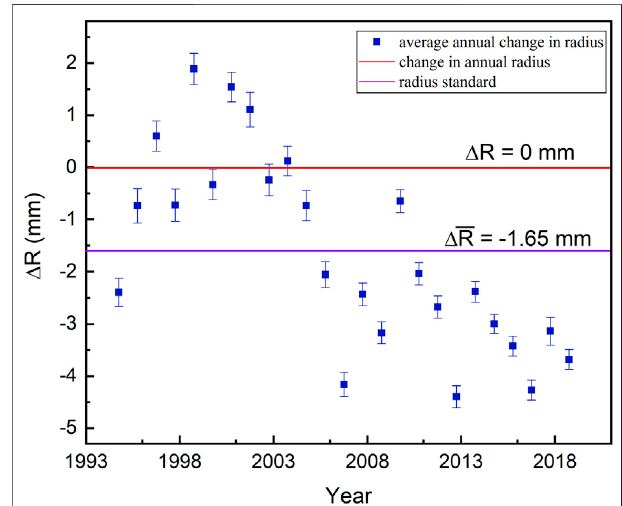
FIGURE 4 | Annual average radius changes of the Earth from 1995 to 2019. Black circles: average change of Earth ’ s radius in that year; red and purple lines represent the annual average radius change (0 and − 1.65 mm yr − 1 , respectively). 20 out of 25 results are negative.